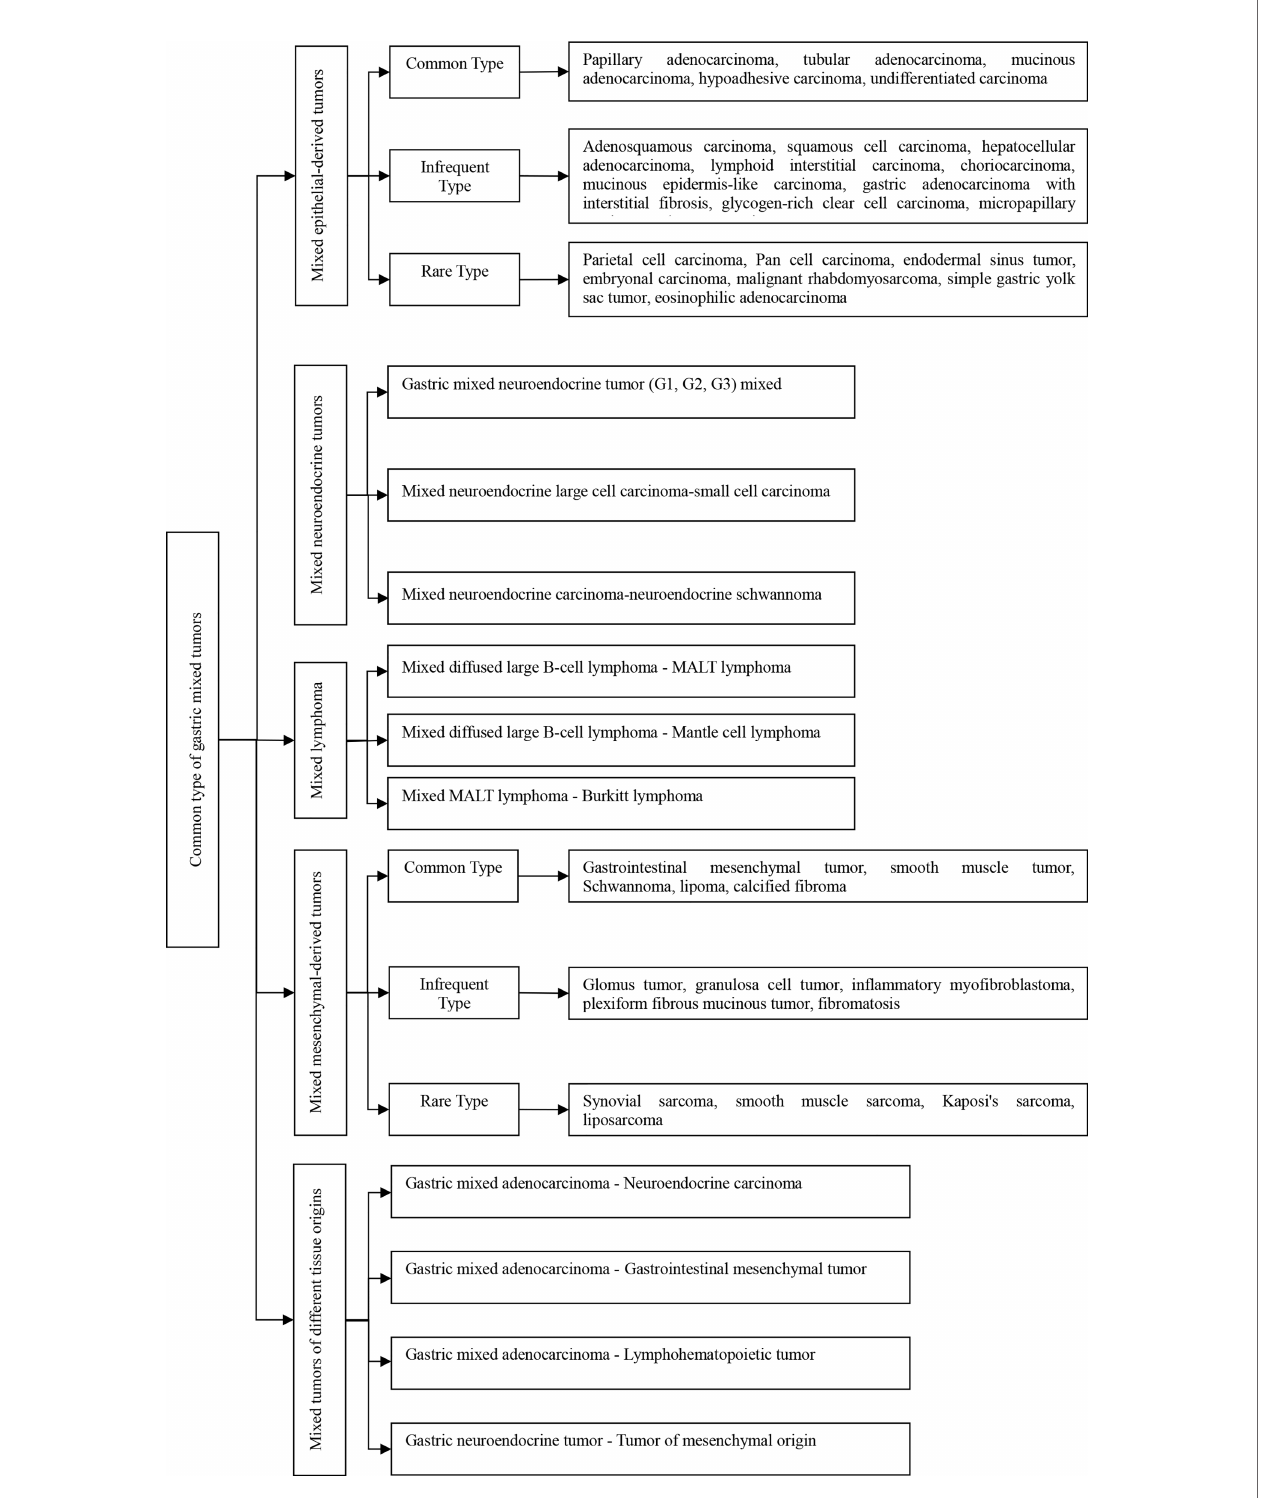
FIGURE 1 | Common types of gastric mixed